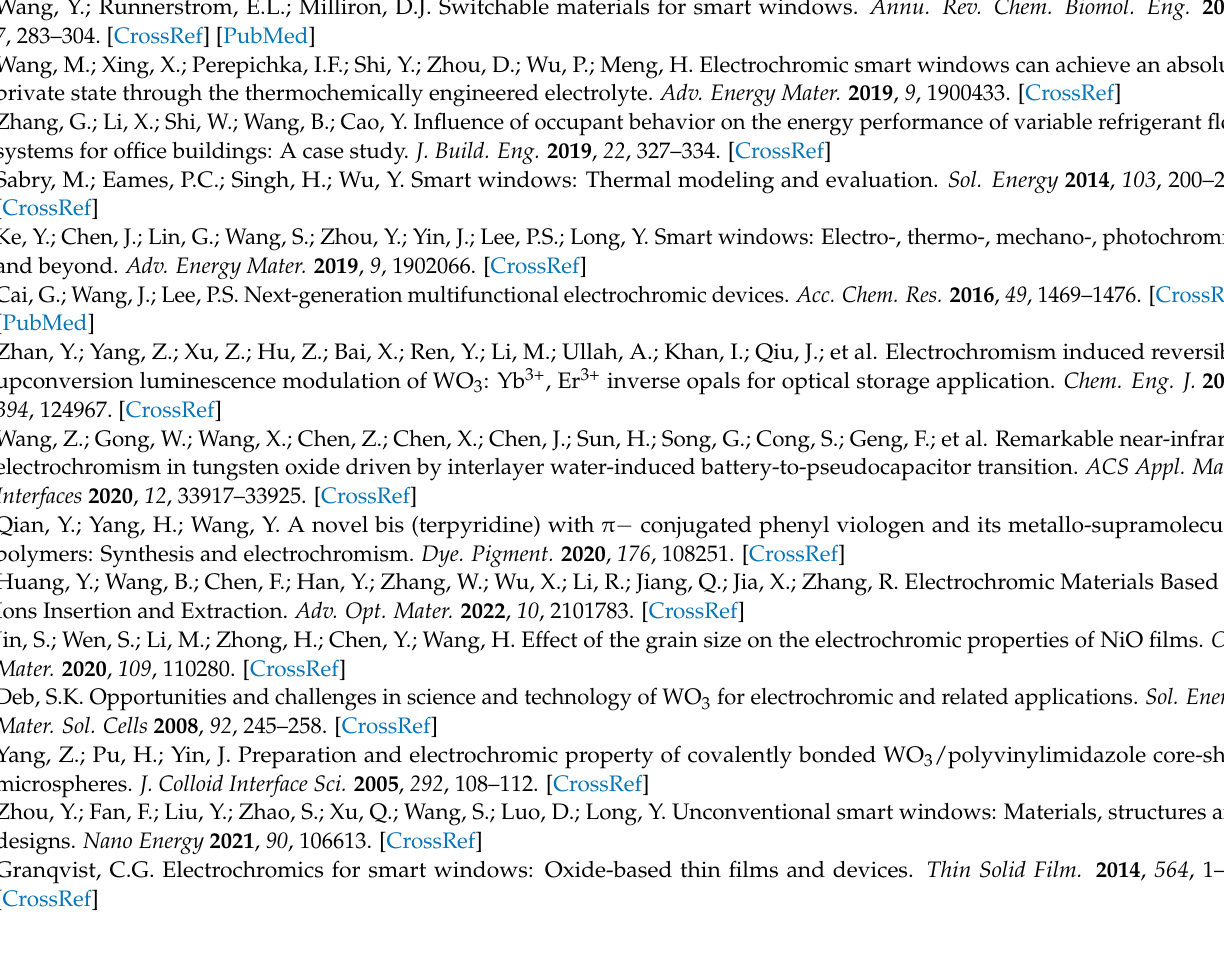
diagrams of different solution samples; Figure S2: The voltage-time diagram of different samples of the experiment; Figure S3: The voltage-time cycle diagram of different samples of the